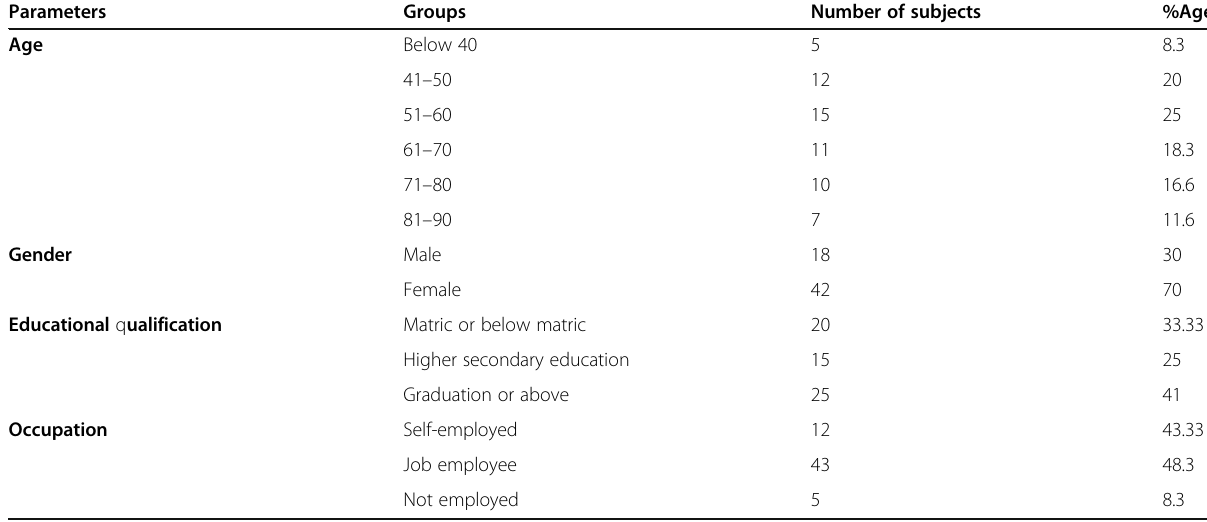
Table 1 Demographic details of rheumatoid arthritis subjects